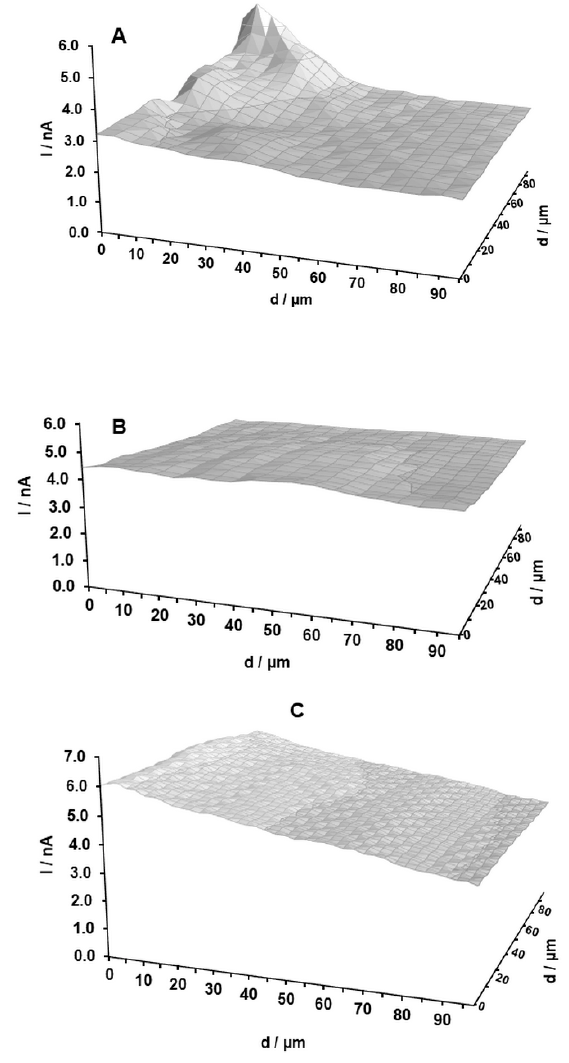
Figure 1. Scanning electrochemical microscopy (SECM) images of the multiwalled carbon nanotube carbon paste electrodes (MWCNT-CPEs): ( A ) 15% MWCNT-CPE; ( B ) 25% MWCNT-CPE; ( C ) 35% MWCNT-CPE. Measurement conditions: Pt ultra-microelectrode (UME) with 10 µ m diameter and RG (the ratio of the insulator radius to the electrode radius) ≥ 10, FcOH 0.2 mM, and KCl 0.1 M; 0.6 V was applied at the tip; the scan rate of the tip to the substrate was 0.5 µ m · s − 1 . The tip approached to the substrate until i T = 1.25 i T , ∞ .